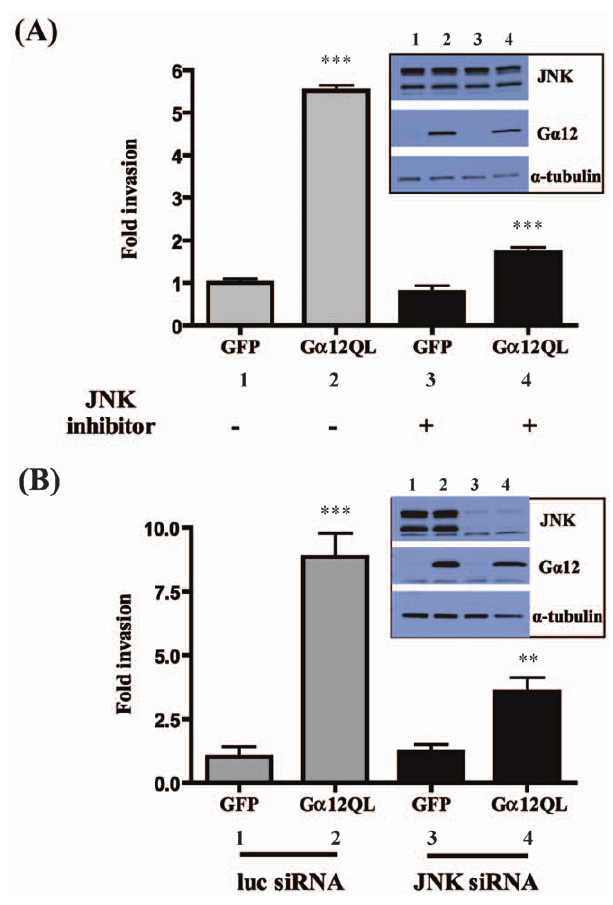
Figure 2. G a 12QL promotes cell invasion through activation of JNK. MDA-MB-231 cells were infected with GFP (control) or G a 12QL adenovirus for 6–7 h and starved for , 20 h. (A) Cells were pre-treated for 2 h with JNK inhibitor SP600125 (20 m M) and allowed to invade Matrigel for 24 h, in the presence of the inhibitor or vehicle control, in a transwell invasion assay (see Materials and Methods ). (B) Cells were transfected with JNK siRNA or control (luc) siRNA for , 72 h before being infected with adenovirus. Cells expressing G a 12QL or GFP were allowed to invade Matrigel for 24 h. For both panels, the invasion assay was set up towards 5 m g/ml fibronectin. Cells that invaded were stained and counted in four random optical fields for each transwell, with three transwells per condition. Results are expressed as fold change in invasion compared to vehicle-treated GFP control cells. The insets show immunoblot analysis of the levels of G a 12, JNK and a -tubulin (loading control). Data is presented as mean 6 SE from a single experiment that is representative of three independent experiments. ** p , 0.01